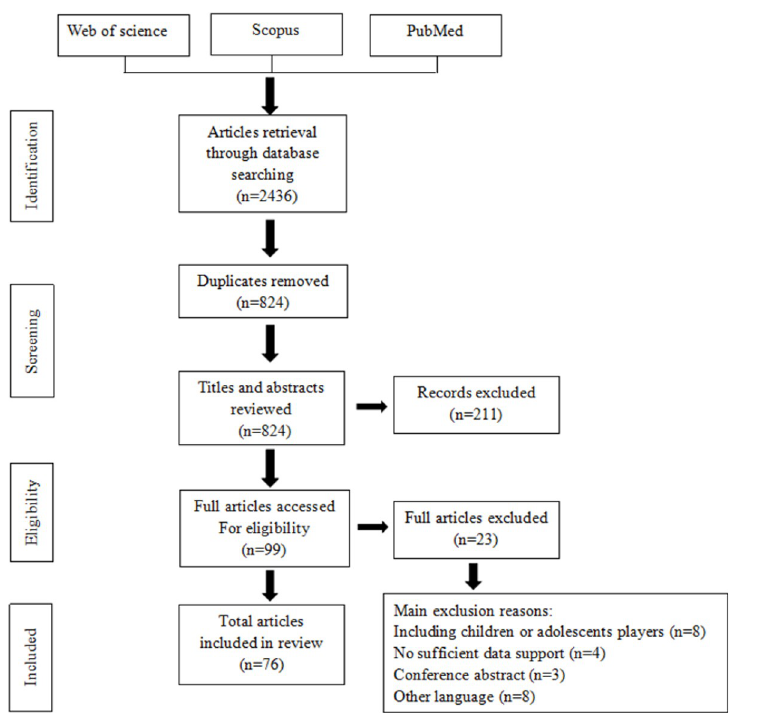
Fig 1. Flow diagram of study selection